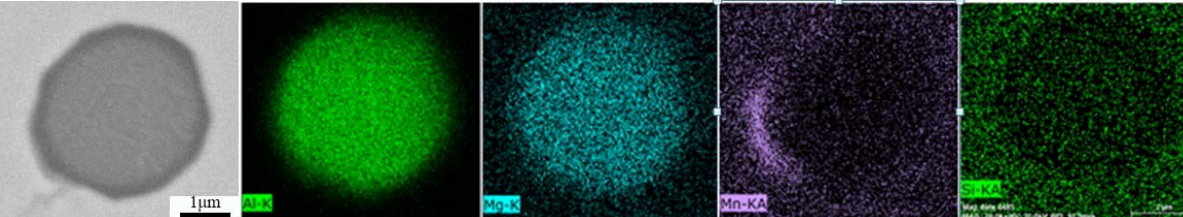
Figure 6: The elemental mapping of typical inclusion in steel when the time of 10min (MgO · Al 2 O 3 )